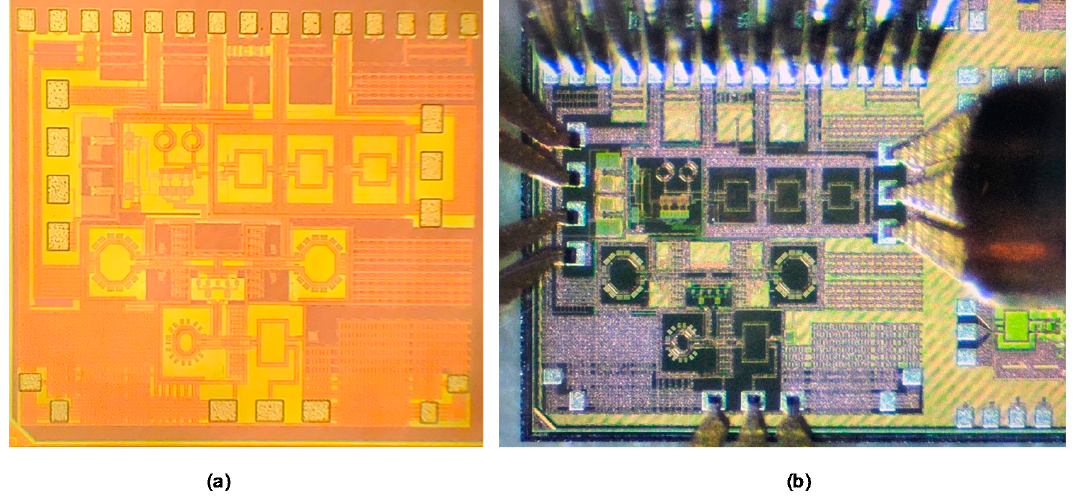
Figure 10. ( a ) Chip micrograph. ( b ) On-wafer probing measurement setup. Figure 11a is the measured input-to-output power transfer characteristic at 28 GHz.